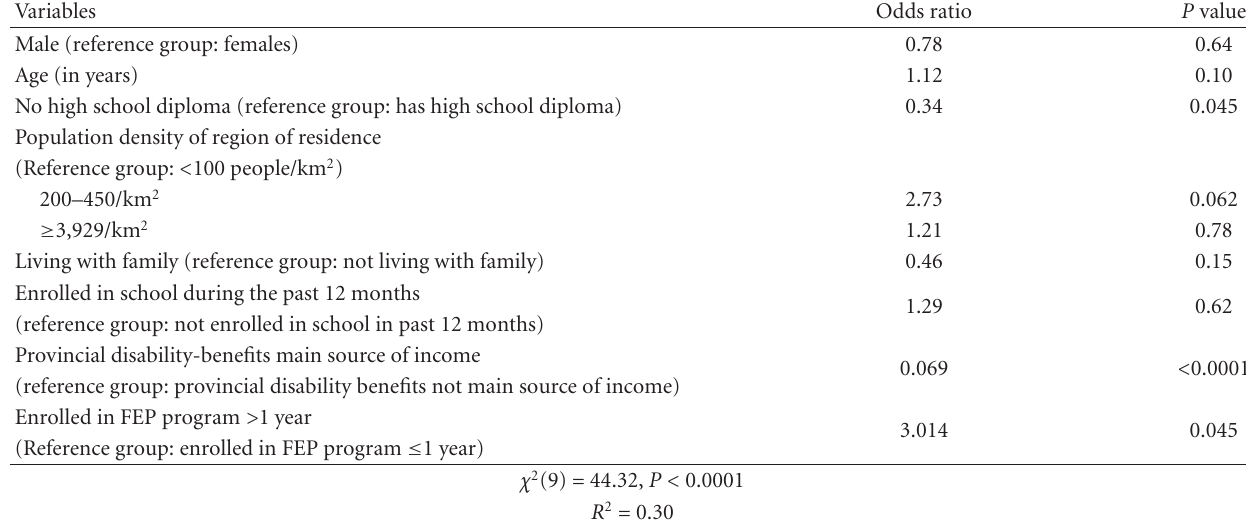
Table 2: Logistic regression results: outcome = paid employment during past 12